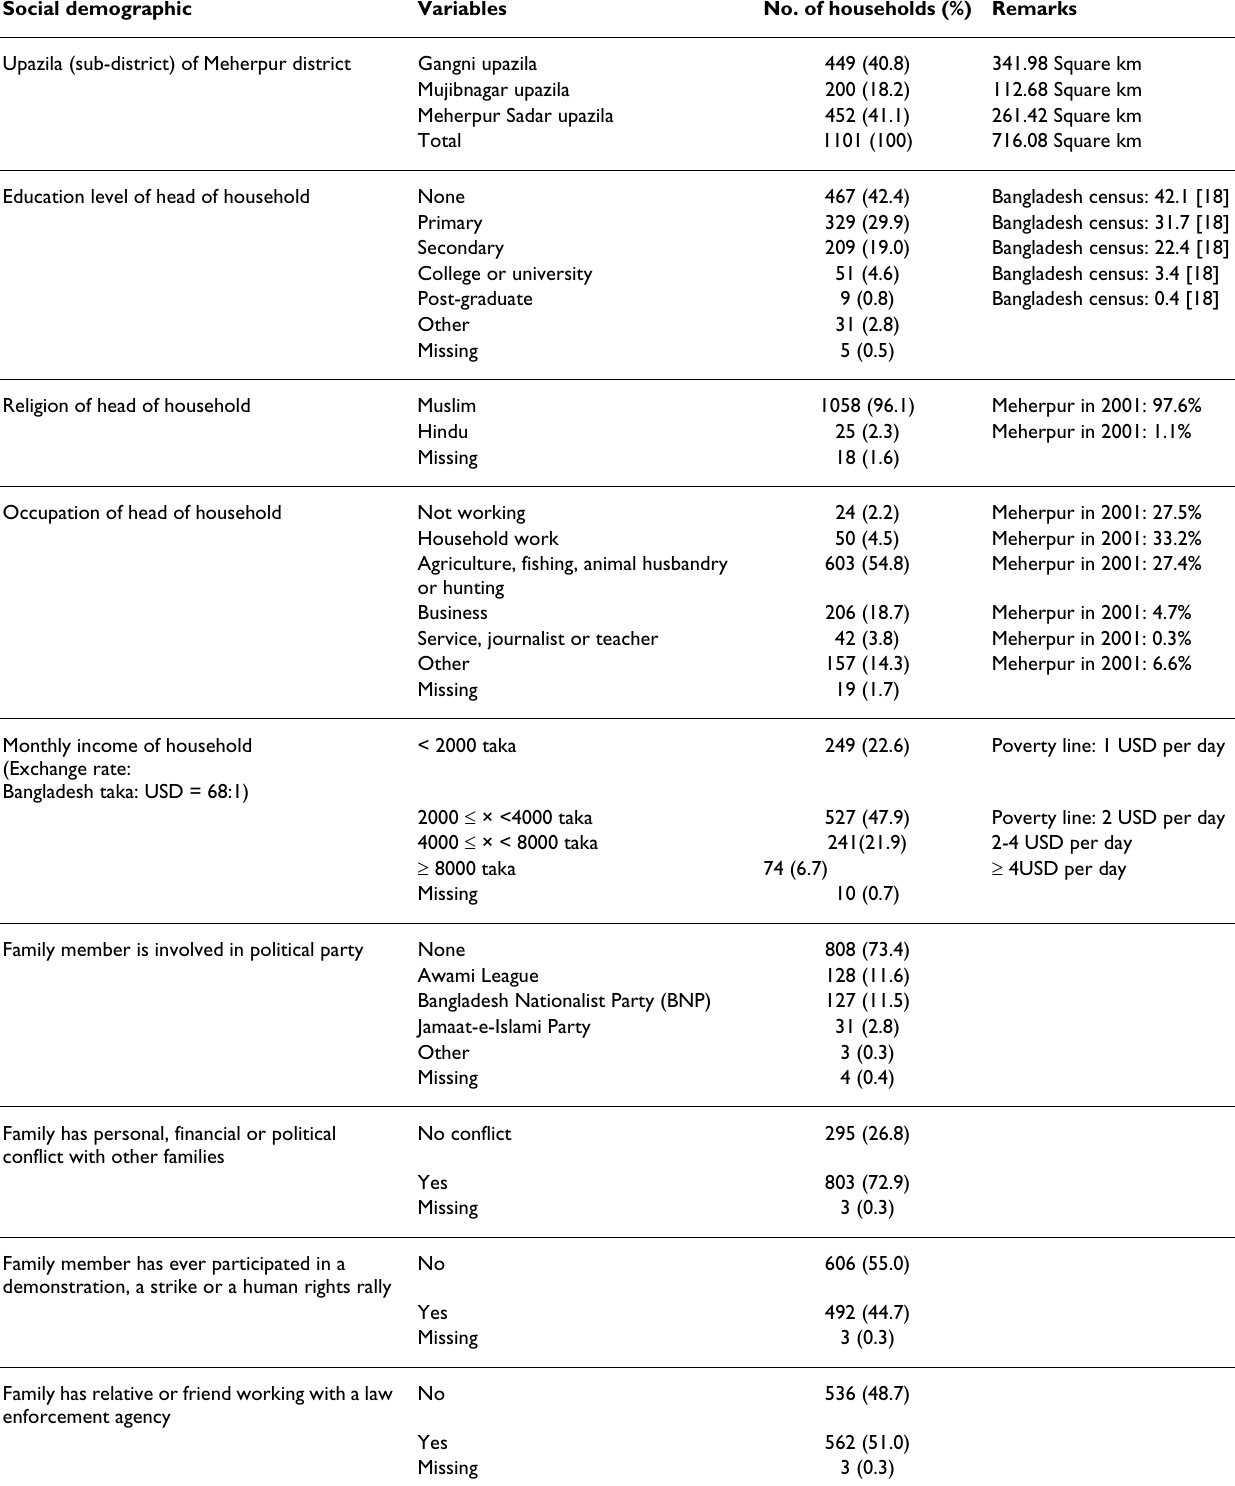
Table 1: Social demographic profile of sampled households, n = 1101 Social demographic Variables No. of households (%)